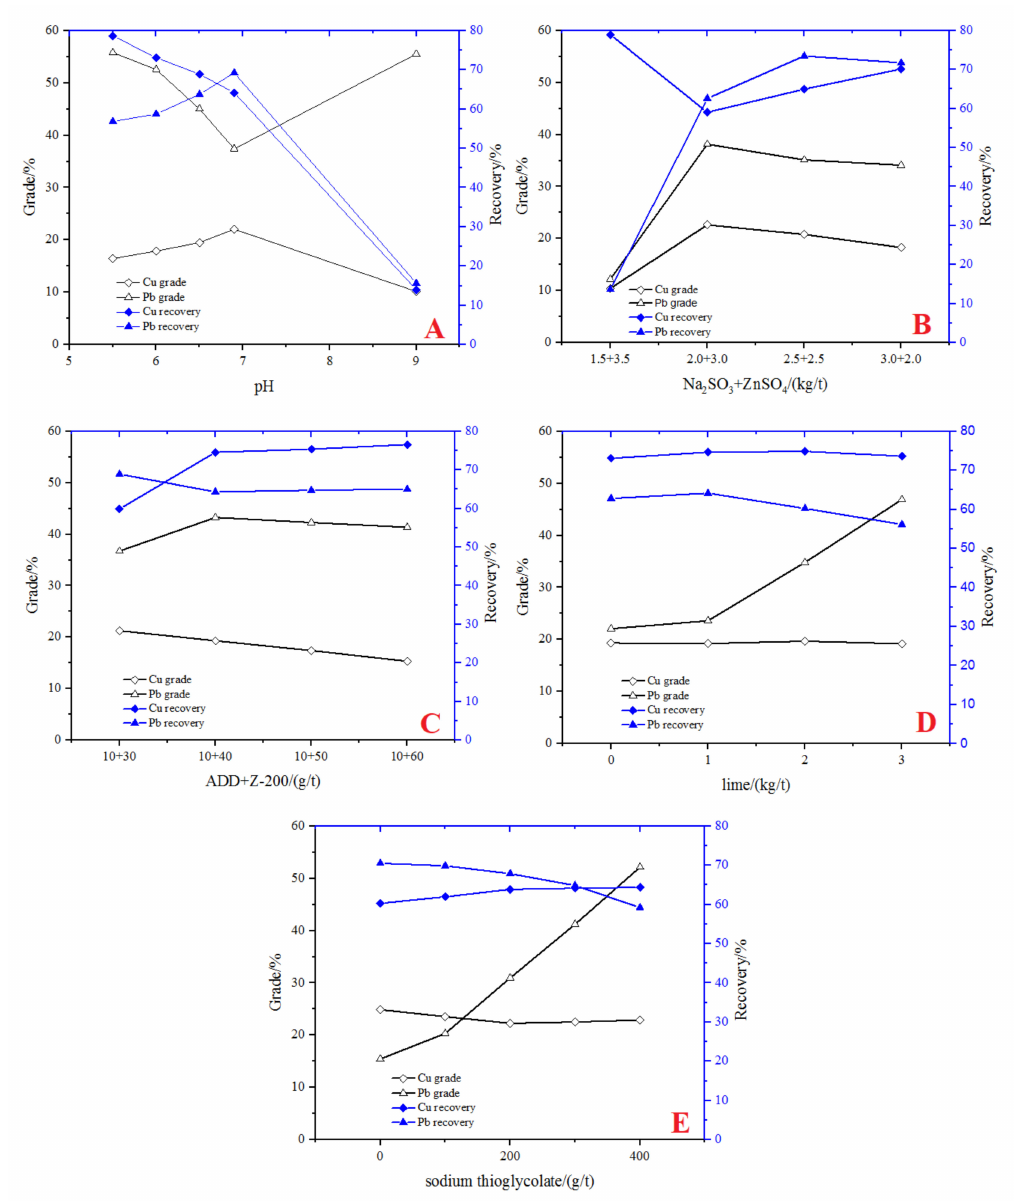
Figure 8. Effects of flotation parameters on Cu-Pb recovery: ( A ) slurry pH, ( B ) Na 2 SO 3 + ZnSO 4 dosage, ( C ) ADD + Z-200 dosage, ( D ) lime dosage and ( E ) sodium thioglycolate